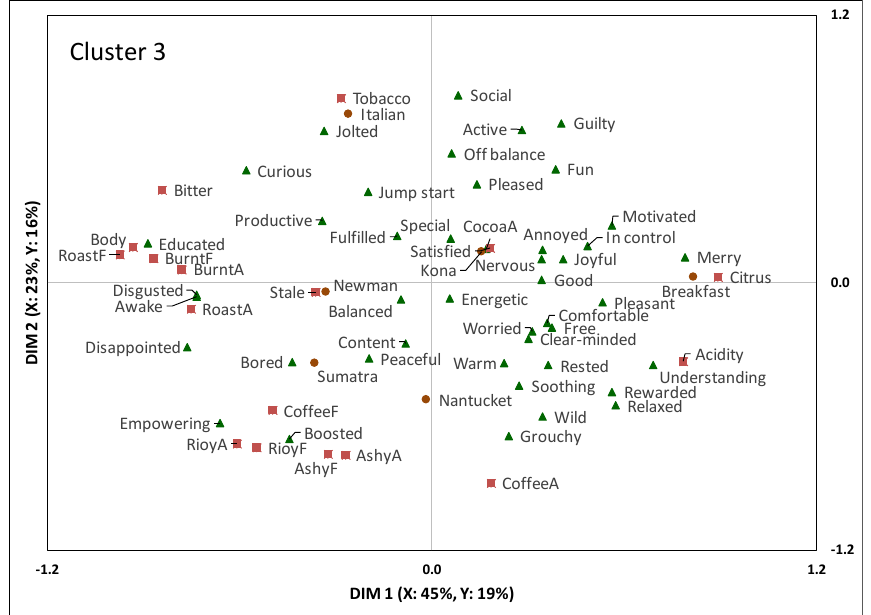
Figure 5. Partial least square regression analysis of descriptive sensory and CDE emotion lexicon of the six coffee samples for consumer Cluster 3.